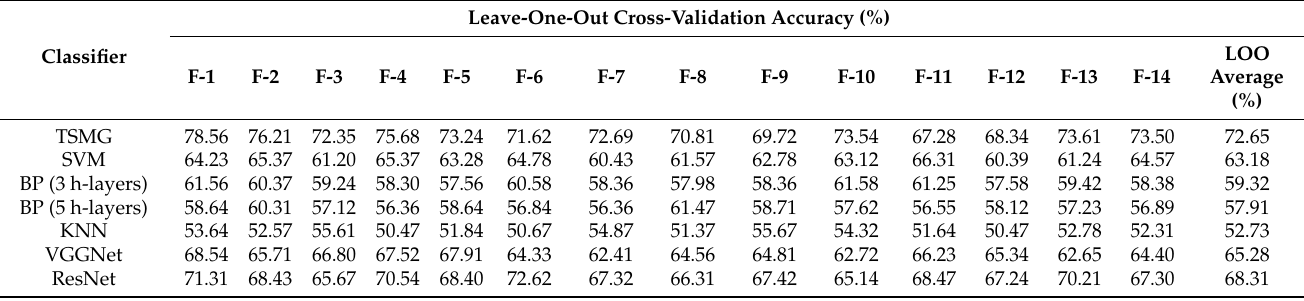
Table 4. Leave-one-out cross-validation on the TSMG, SVM, KNN, BP, VGGNet, and ResNet. Leave-One-Out Cross-Validation Accuracy Classifier